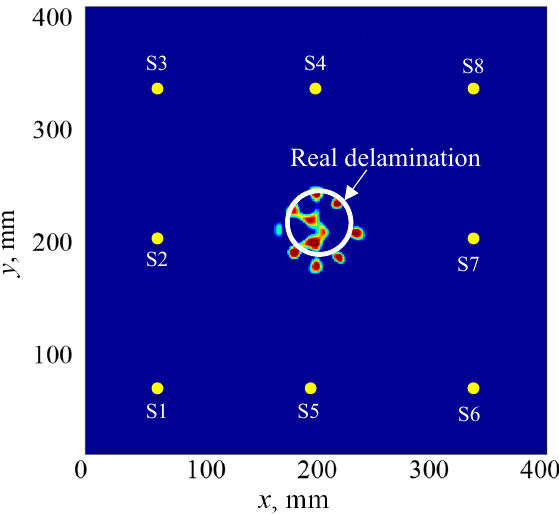
Figure 19. The imaging result of the 50 mm delamination in the cross-ply composite plate.